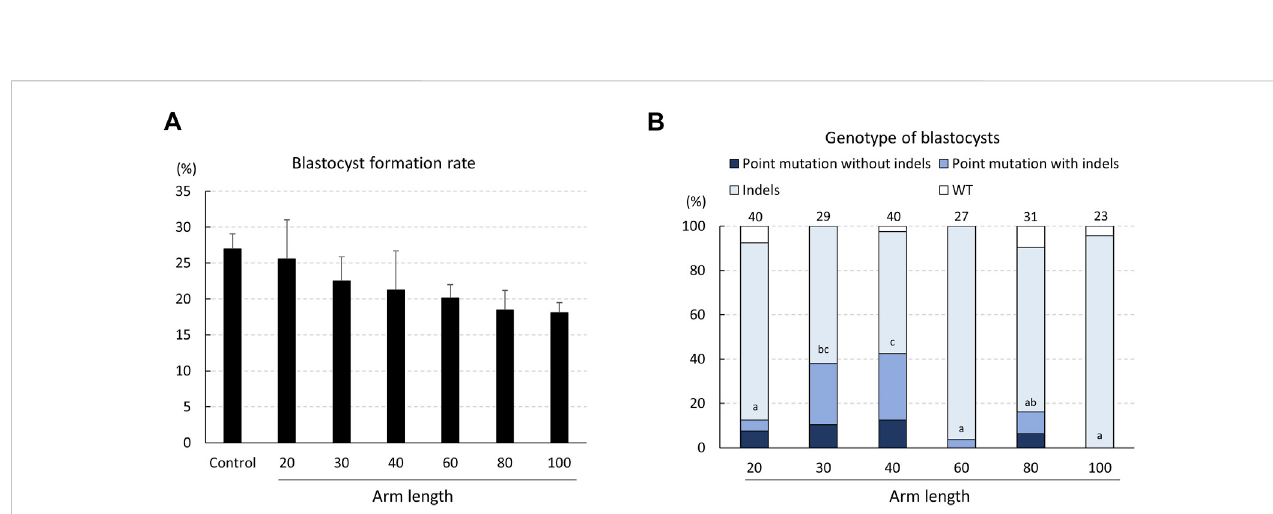
FIGURE 3 Rates of blastocyst formation (A) and genotypes of blastocysts (B) developed from zygotes electroporated with the CRISPR/Cas9 system targeting the INS gene and single-stranded oligodeoxynucleotide (ssODN) with different homology arm lengths. The percentages of point mutations and indels indicate the ratio of the number of blastocysts carrying a point mutation/indel to the total number of blastocysts examined. Four replicate trials were carried out and numbers above the bars indicate the total number of blastocysts examined. Point mutation without indels, blastocyst carrying a point mutation without another mutation; Point mutation with indels, blastocyst carrying a point mutation with another mutation; Indels, blastocyst carrying mutations around the gRNA-targeting site; WT, wild-type. Error bars indicate the mean ± SEM (A) . a – c p <